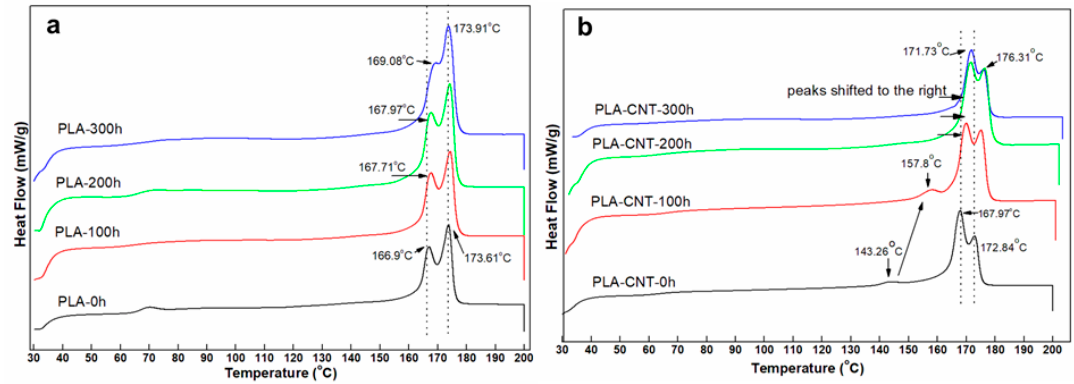
Figure 5. DSC of PLA ( a ) and PLA-CNT ( b ) after degradation.